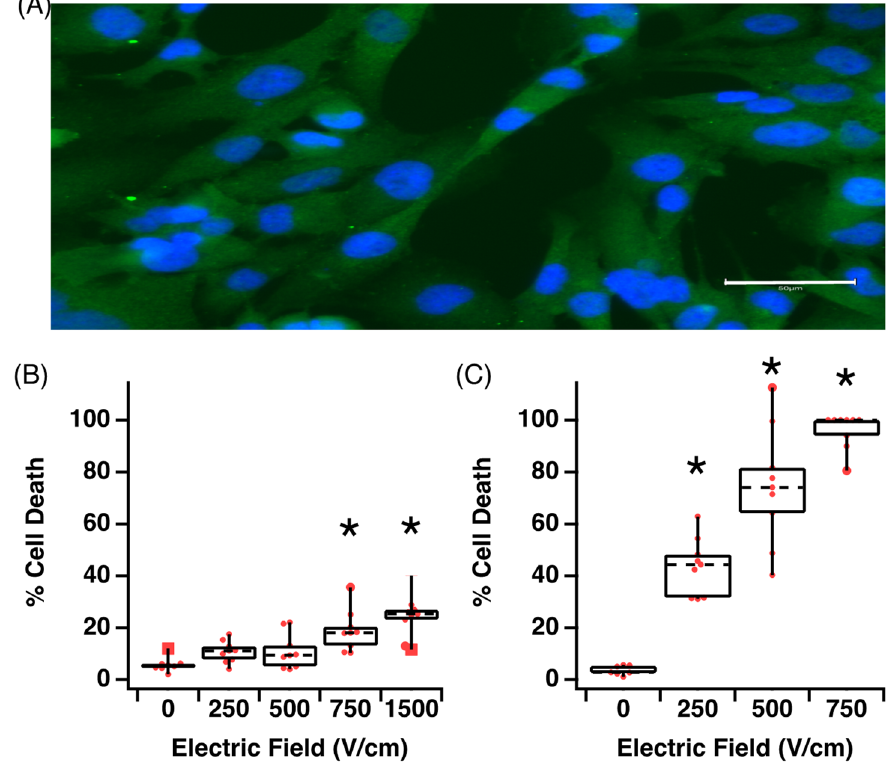
Figure 2. Increasing electrical field strength increases cell death in human cardiomyocytes. ( A ) AC16 cells in culture stained positive for phenotypical markers of human cardiomyocytes, scale bar 50 µ m. ( B ) Effect of field strength on cell death with a 3 ms total on-time. ( C ) Effect of field strength on cell death with a 60 ms total on-time. Data are representative of at least 3 independent experiments and plotted as max, min and median. * p < 0.05, one-way ANOVA, Dunnett’s post-hoc test.